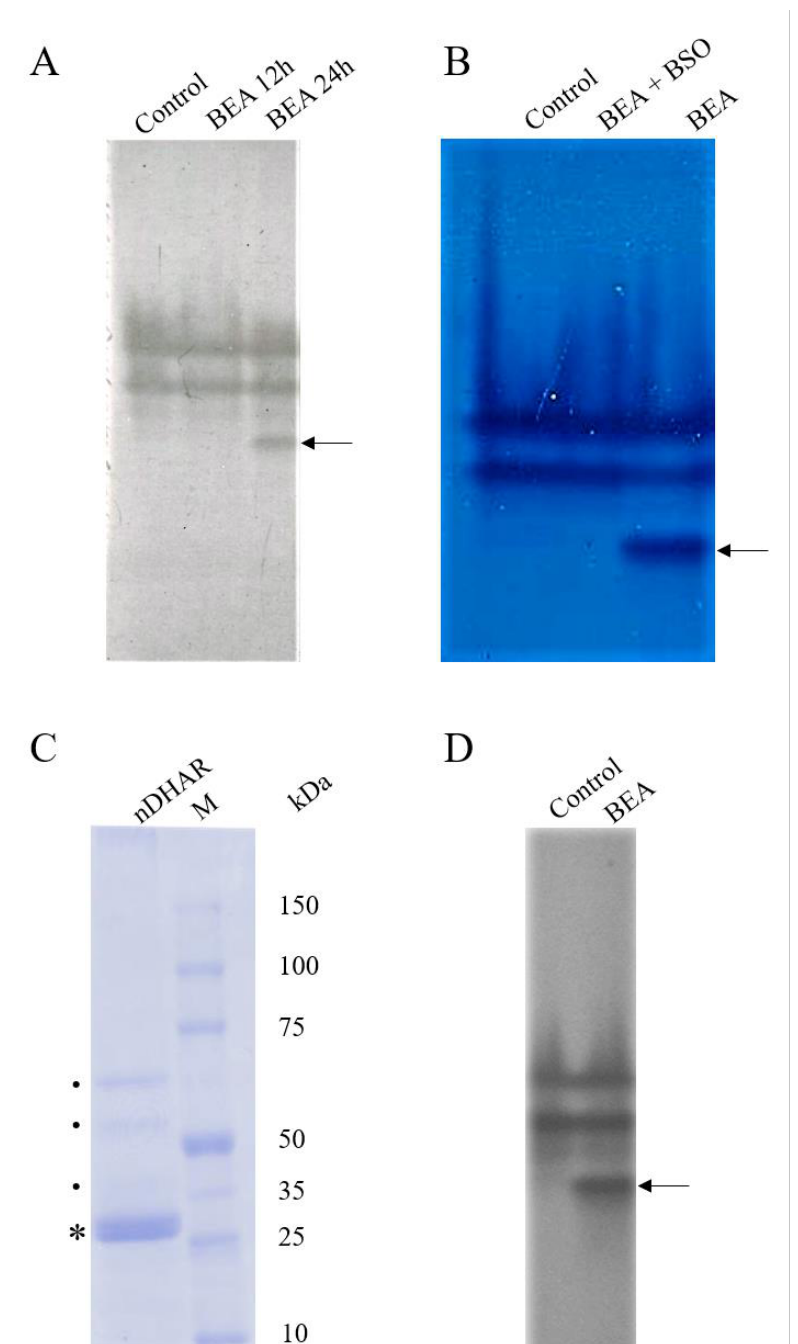
Figure 4. Electrophoretic analysis of DHAR proteins. ( A ) Native-PAGE of the cytosolic extract of the control and beauvericin (BEA) treated sample using DHA and GSH as substrates after 12 h and 24 h; ( B ) Native-PAGE of the cytosolic extract of the control, BEA and BEA plus BSO treated samples after 24 h; ( C ) SDS-PAGE of the novel band (nDHAR) eluted from the native-PAGE. The asterisk (*) in (Panel C ) indicated the band subjected to mass spectrometry analysis. while the dots ( • ) indicated the other visible minor bands; ( D ) Western blot of the cytosolic fraction of the control sample and BEA; the experimental procedure is given in Section 2.7. Arrows in Panel A, B, and D indicate the novel DHAR. BEA = beauvericin; BSO = Buthionine-[ S , R ]-sulfoximine; M = Molecular weight marker.